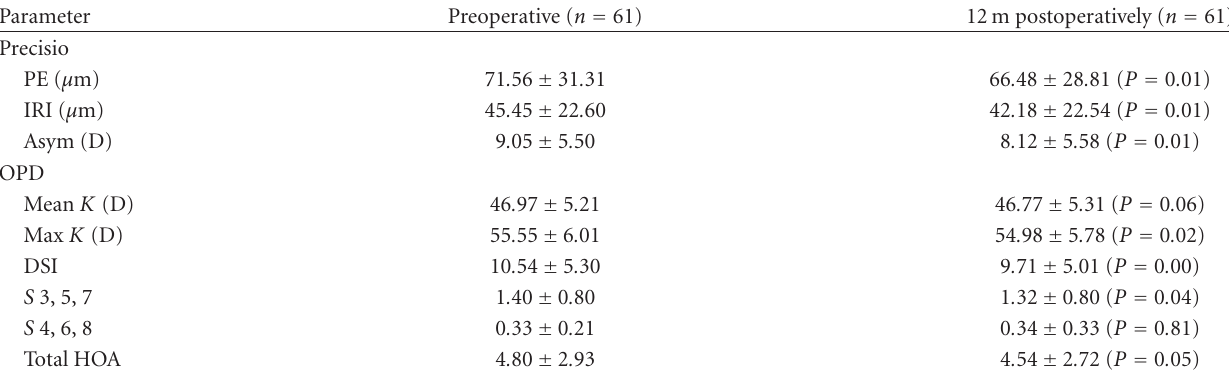
Table 2: Topographic changes during 1-year